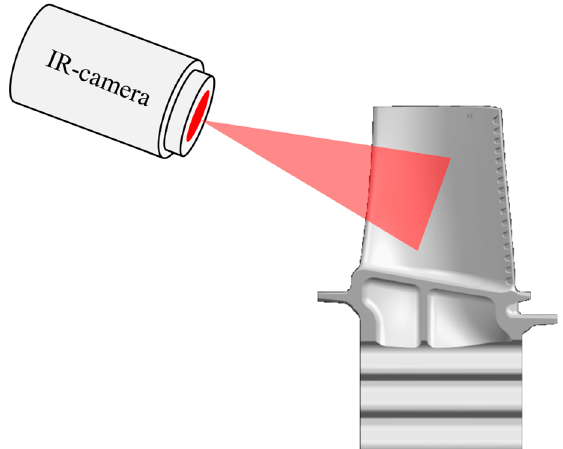
Figure 21. Principle infrared thermography.